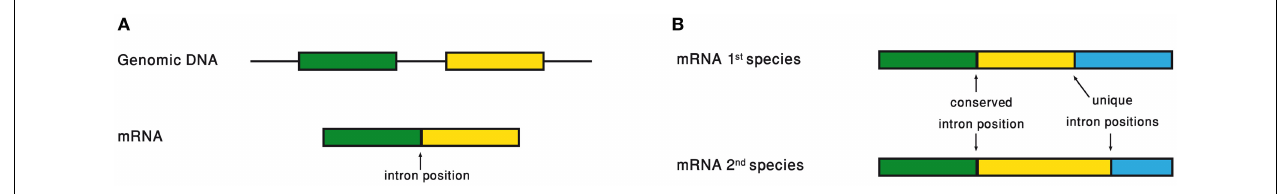
FIGURE 3 | (A) Intron position is defined as the point of intron insertion along the mRNA. (B) Comparison of intron positions between orthologous